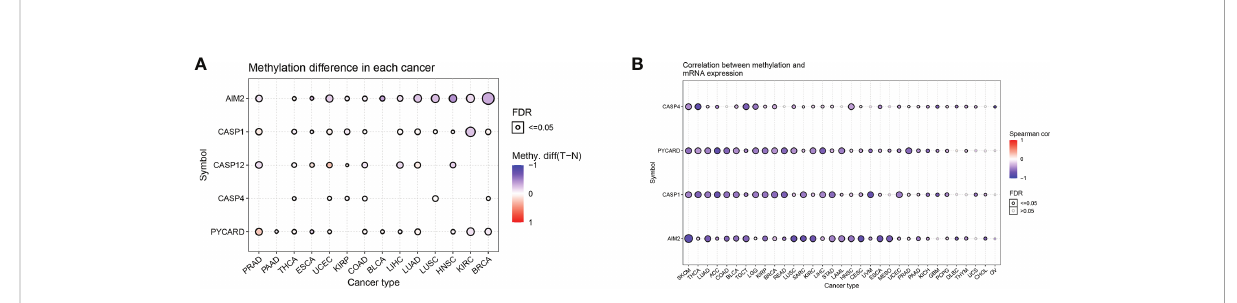
FIGURE 3 Differential methylation analysis of AIM2 in fl ammasome-related genes in pan-cancer (A) Differential methylation of AIM2i-RGs in 14 tumors. The different shades of color indicate the magnitude of the methylation levels, with red dots representing increased methylation in tumors and blue dots representing decreased methylation in tumors (Student ’ s t-test). (B) Correlation of methylation with the mRNA gene expression. The different shades of color indicate the magnitude of the correlation, with red dots representing positive correlation and blue dots representing negative correlation (Spearman ’ s correlation